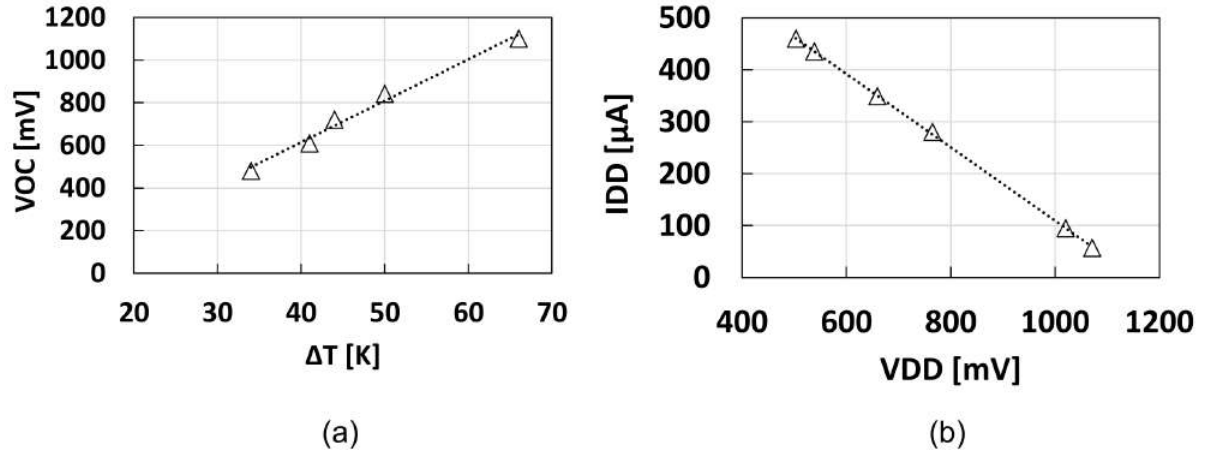
Figure 11. V OC vs. D T ( a ) and I DD vs. V DD at D T of 66 K ( b